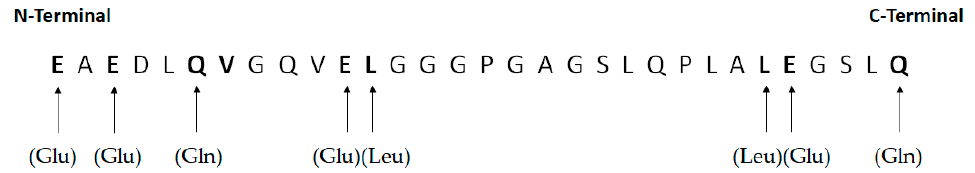
Figure 1. Amino acid sequence of human C-peptide: E (glutamic acid, Glu), A (alanine), D (aspartic acid) L (leucine, Leu), Q (glutamine, Gln), V (valine), G (glycine), P (proline) and S (serine) (Adapted from [49] ).